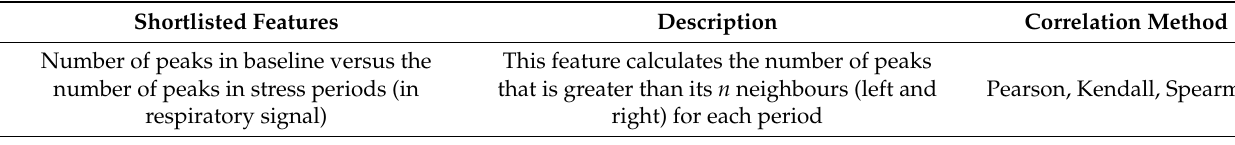
Table 6. Description of calculated features and correlation analysis